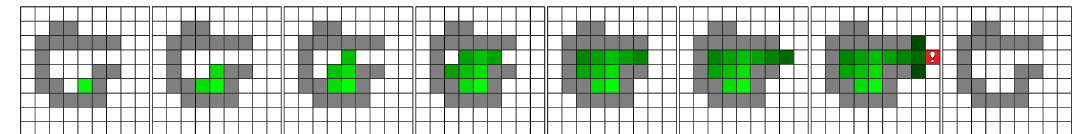
Figure 6. Filling a closed area. Gray areas denote the voxels of the surface; green ones refer to voxels filling the internal voids of the approximated model.